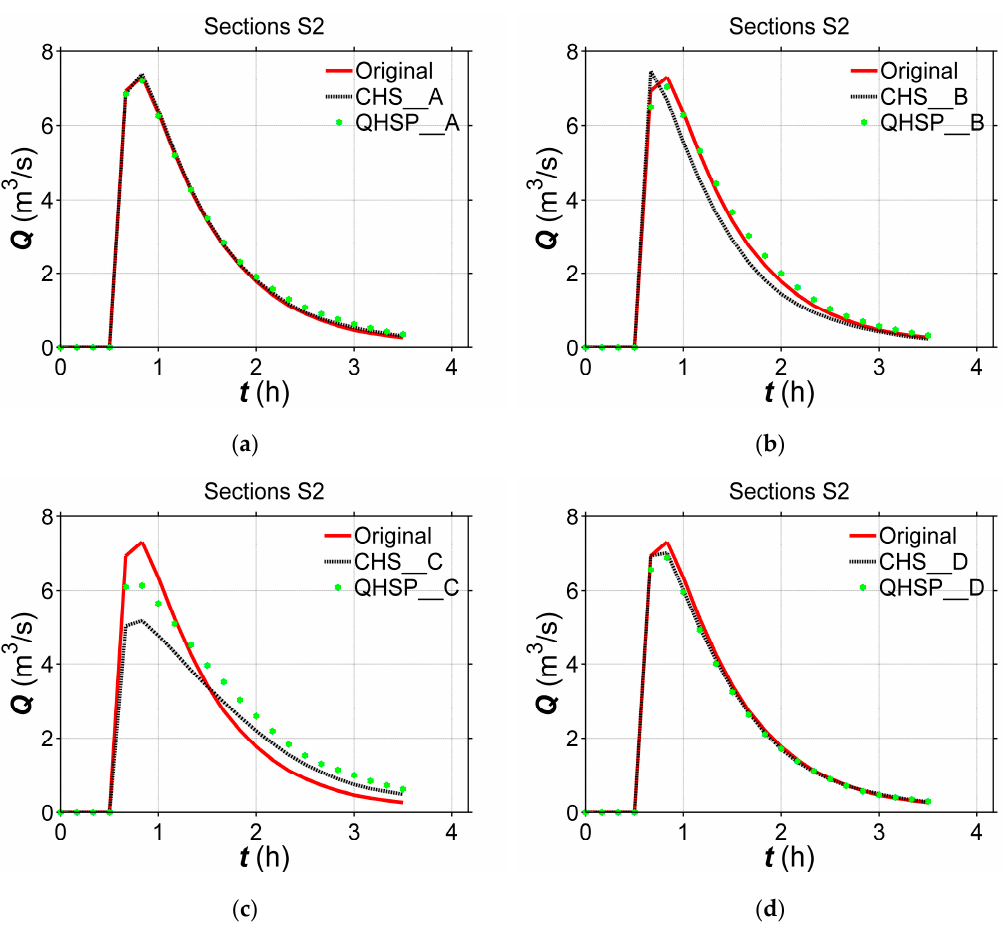
Figure 11. Computed hydrograph for test case ( a ) A, ( b ) B, ( c ) C, and ( d ) D at Section 1 in the constructed river with the amplitude of 600 m.